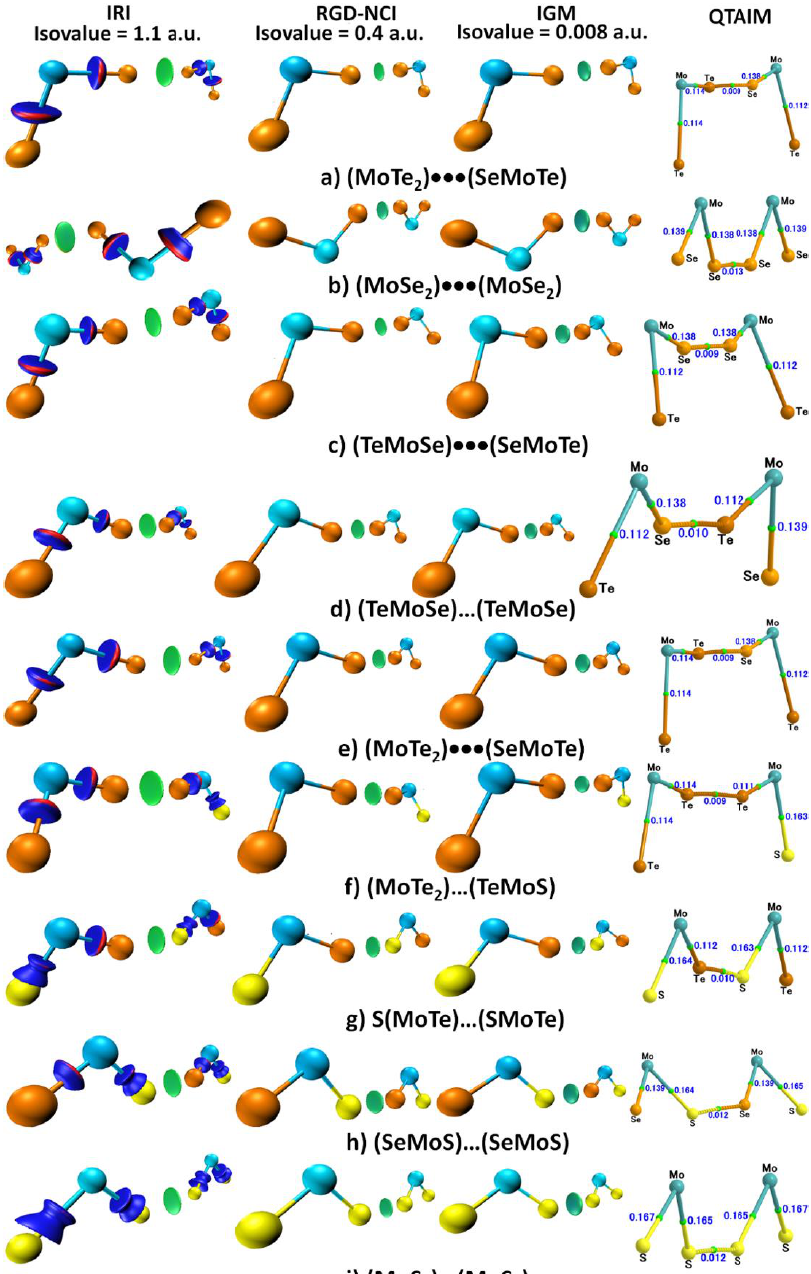
Figure 5. MP2(Full)/def2-TZVPPD computed IRI, RDG and IGM-based isosurfaceplots between bonded atomic basins for all the nine dimers examined. Isosurfaces representing the presence of noncovalent interactions are colored red/blue/green. Included are the QTAIM molecular graphs, with ρ b (a.u.) at